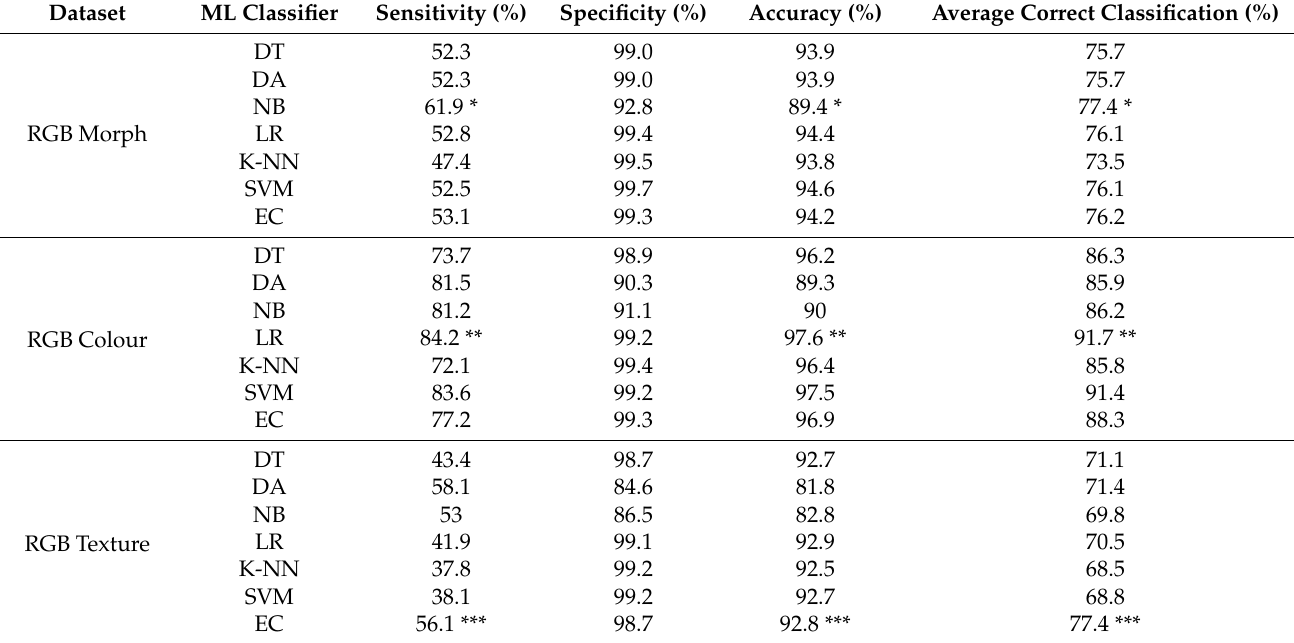
Table 4. The classification performance of the RGB image datasets for the morphology, colour and